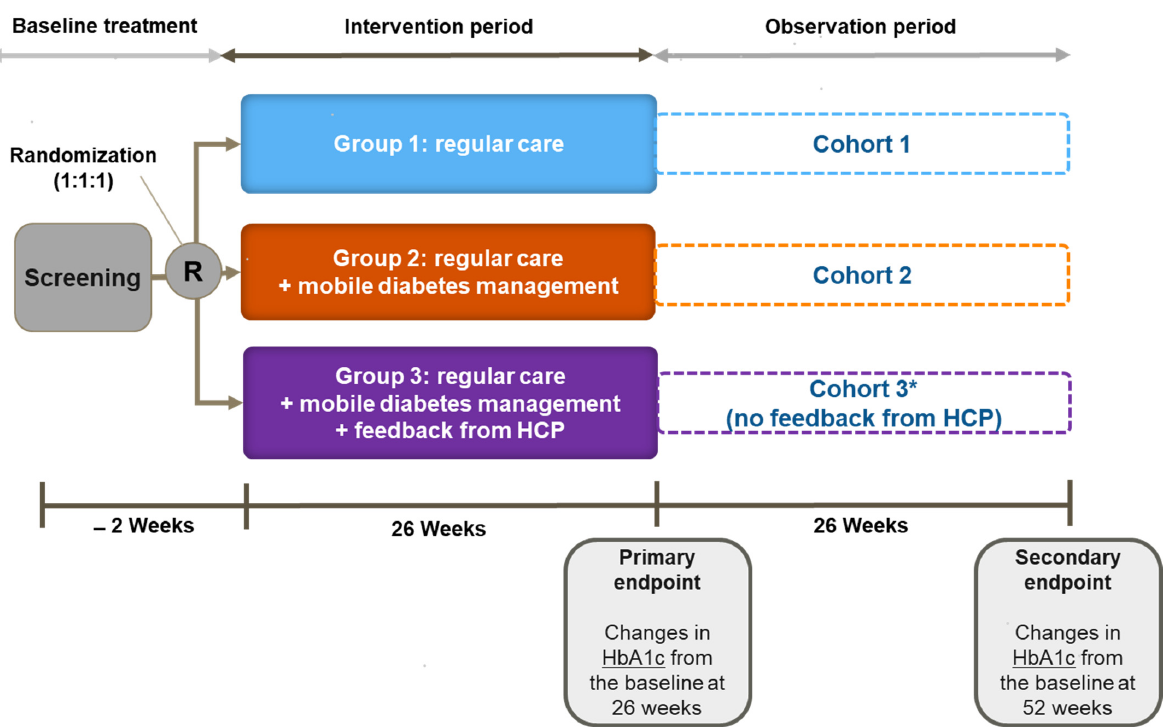
Table 1. Comparison of intervention protocols for each group.